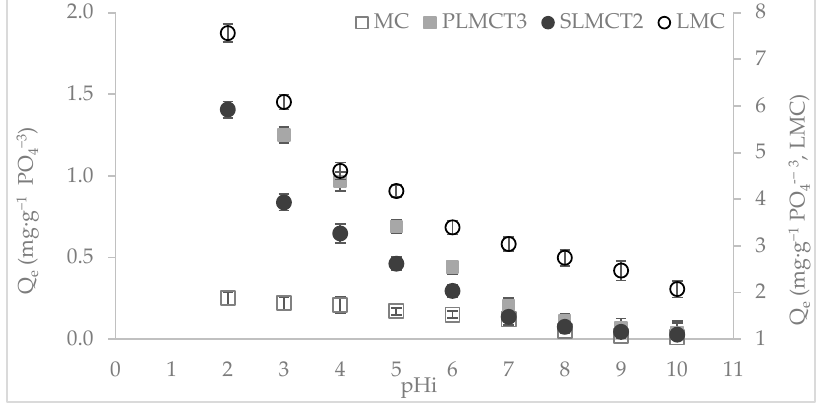
Figure 6. Phosphate adsorption capacity of adsorbents as a function of pH of solution. Values obtained at V: 25 mL, w: 0.25 g and C i : 10–2000 mg·L − 1 PO 43 − ; except for SLMCT 2 w: 10 ± 0.2 g.